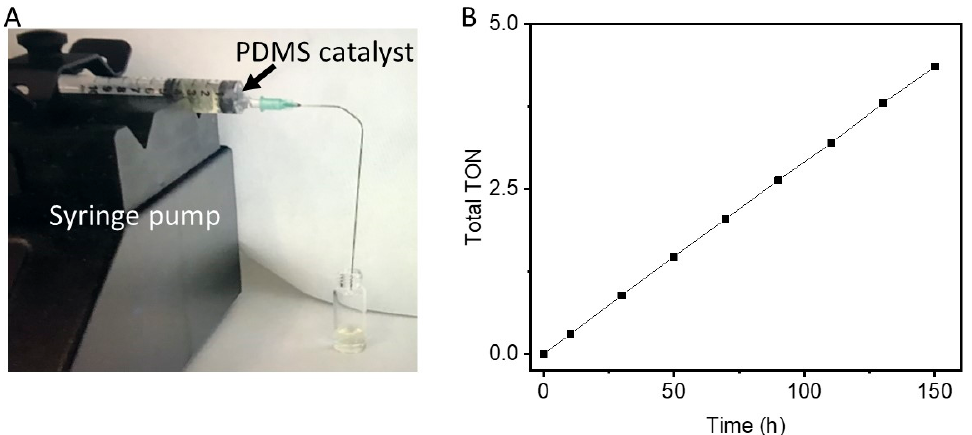
Figure 5. ( A ) Photograph showing the experimental set-up to study the continuous flow reaction. The arrow indicates the Pd-doped PDMS disc located at the end of the syringe. ( B ) Representation of the total TON versus time for the continuous flow reaction for one Pd-doped PMDS as catalyst.